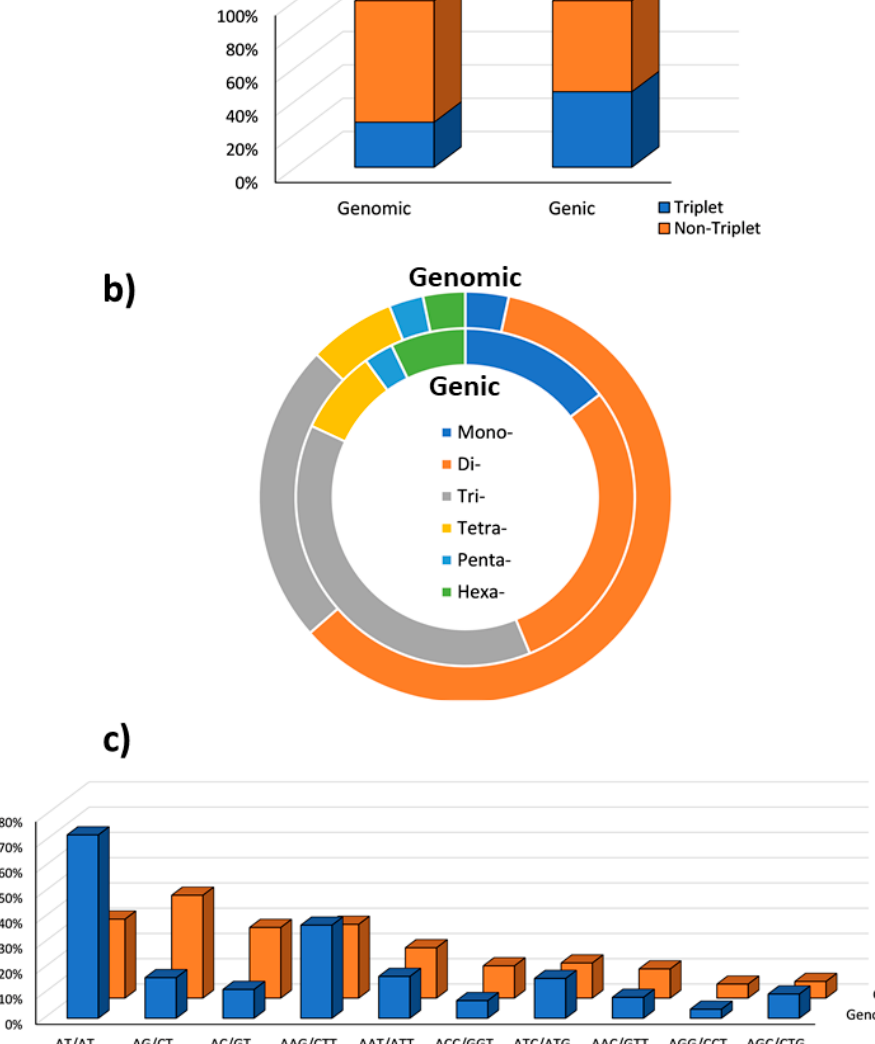
Figure 4. ( a ) Non-triplet SSR vs. triplets SSR; ( b ) distribution of repeat types within perfect and imperfect SSR motifs in both the genomic and genic regions; ( c ) Comparison between di- and trinucleotide repeats in both full genomic regions and gene space.